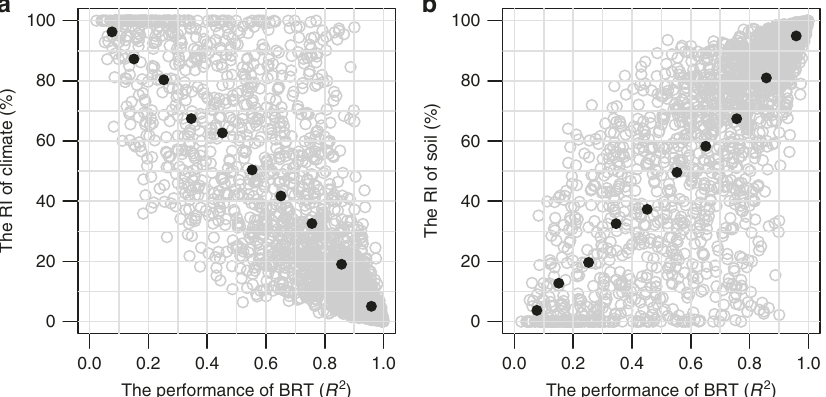
Fig. 5 Relationship between model performance and the relative importance. a , b The relationship between the model performance (indicated by R 2 ) and the overall relative importance (RI) of climate and soil variables, respectively. Grey open circles show the results in each 100 × 100 km window randomly selected for modelling. Black solid circles show the average for each group of R 2 from 0 to 1 with 0.1 increment